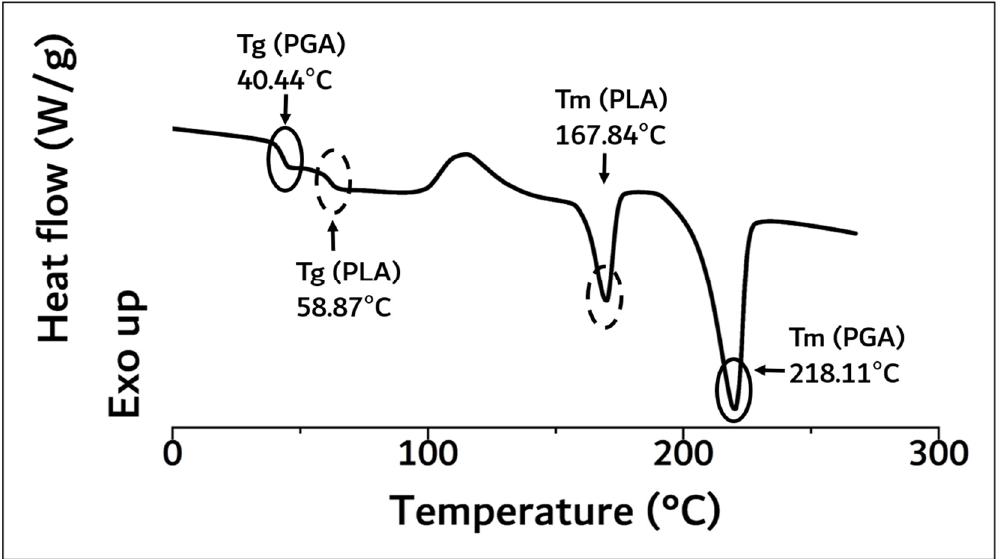
Figure 3. DSC curve of synthesized PGA–PLA block copolymer. (0 °C ~ 270 °C, heating rate: 10 °C/min, 2nd run, N 2(g) condition).